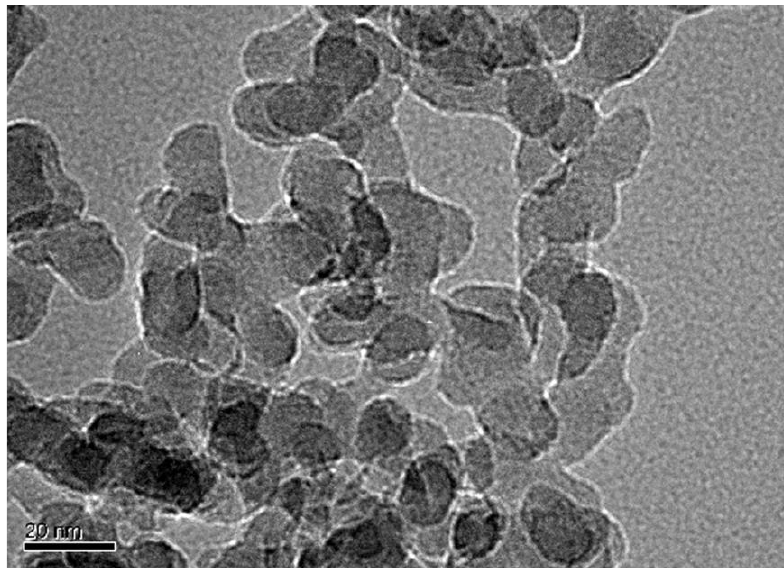
Figure 2. TEM image of CNS. Table 1. Chemical component of Portland cement.